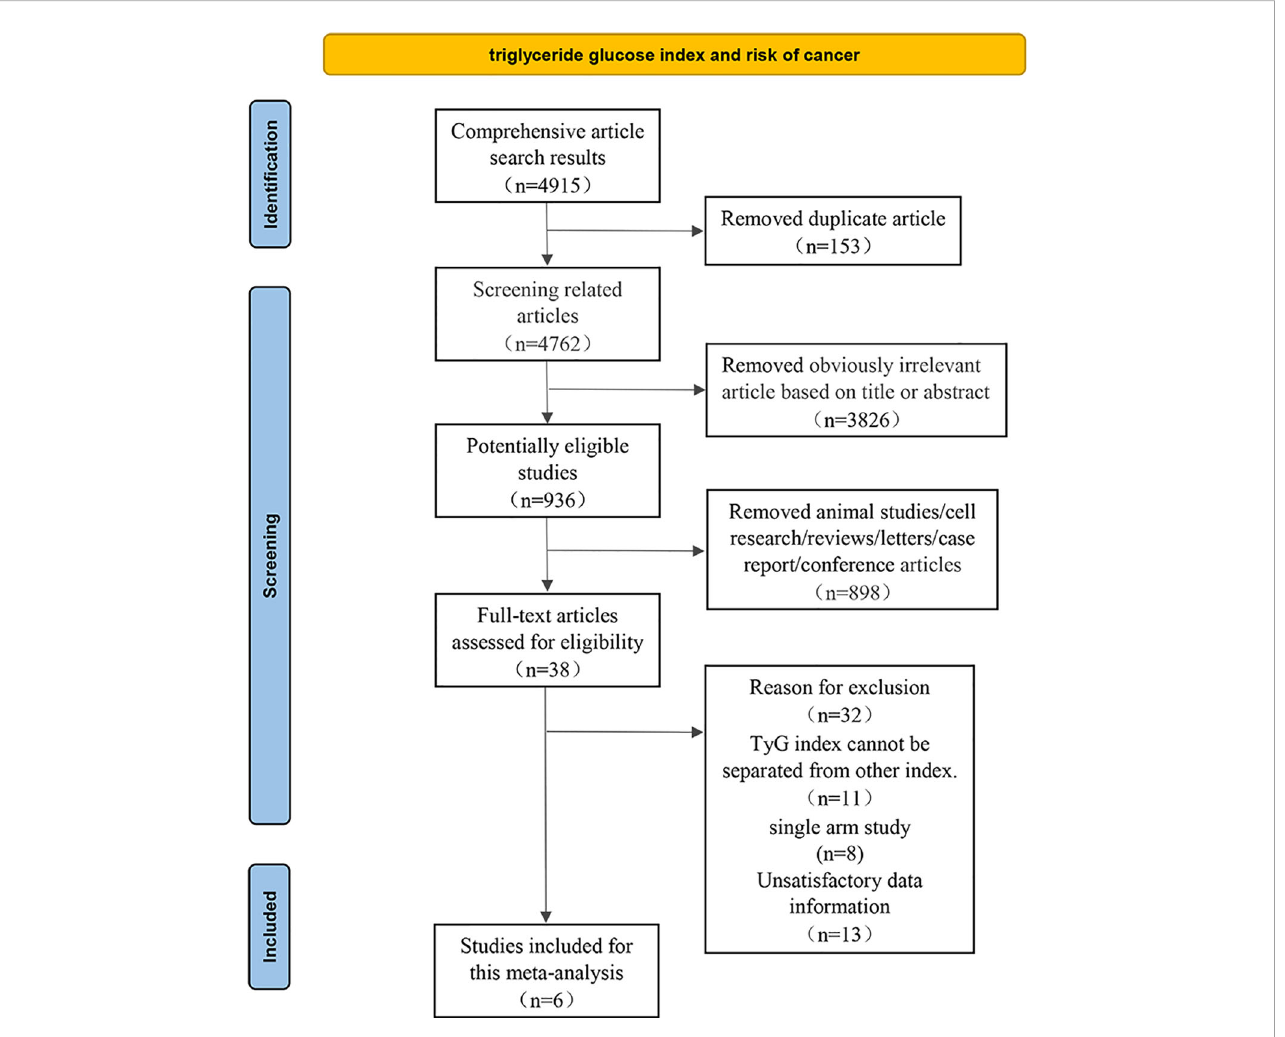
FIGURE 1 Flow diagram of the literature search and